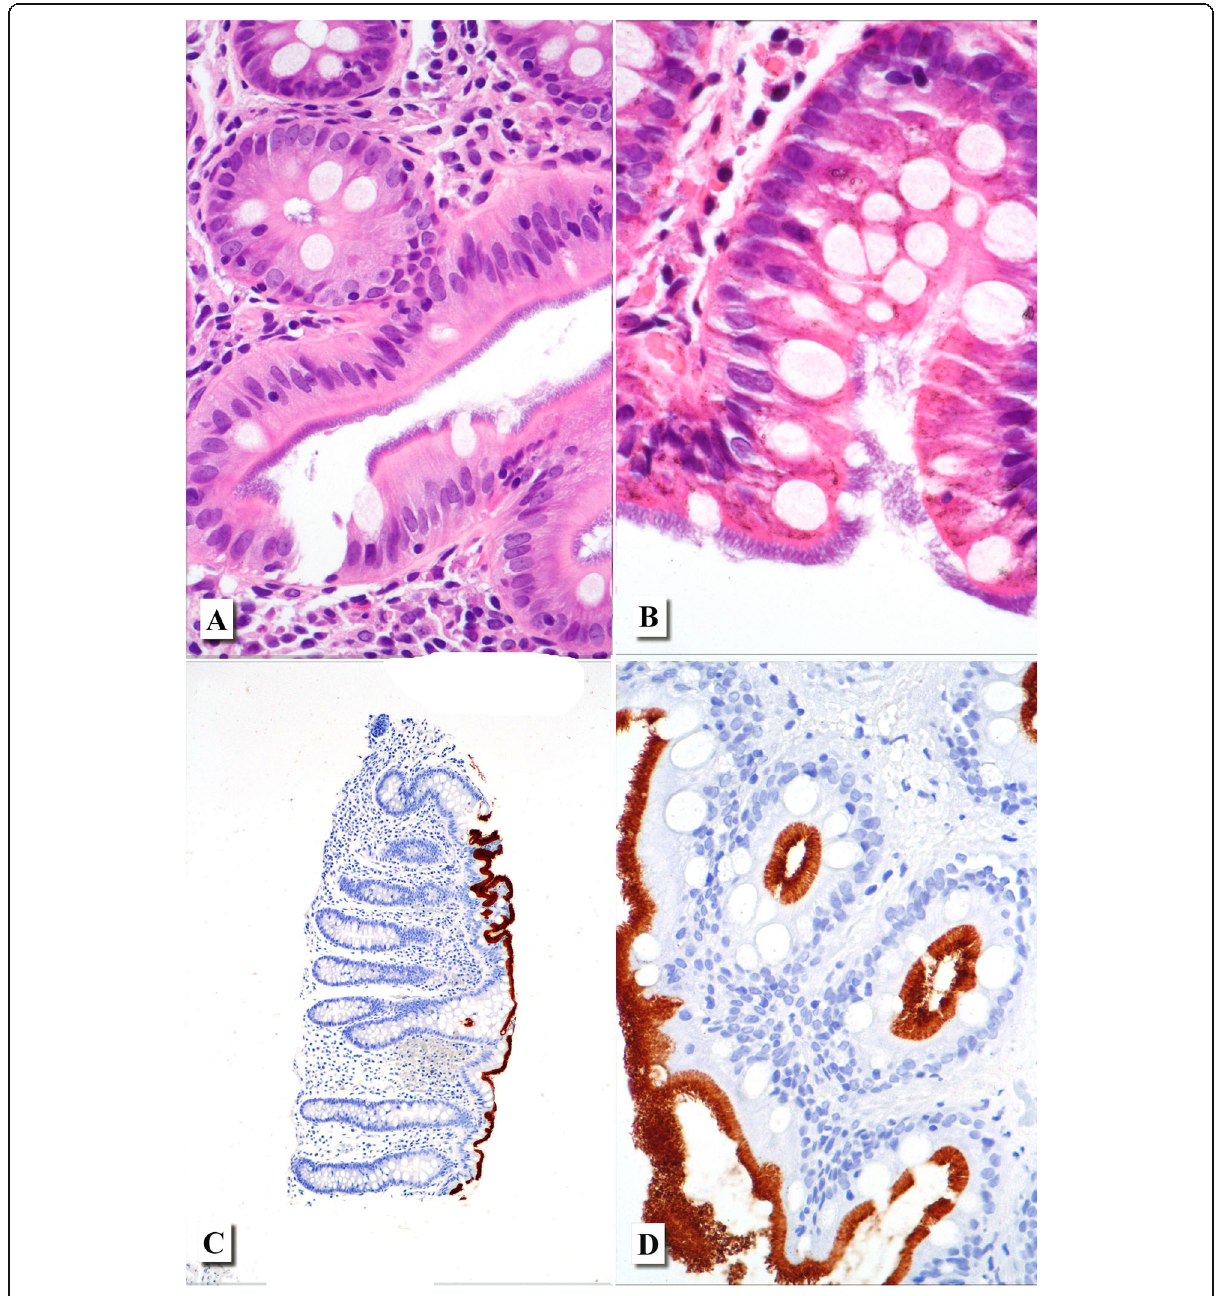
Fig. 3 Photomicrographs of the transverse colon illustrating a dense basophilic surface of spirally shaped organisms seen in all large bowel samples. HE(A: 100x and B:400 magnification) and immunohistochemistry anti-Treponema (C: 40x and D: